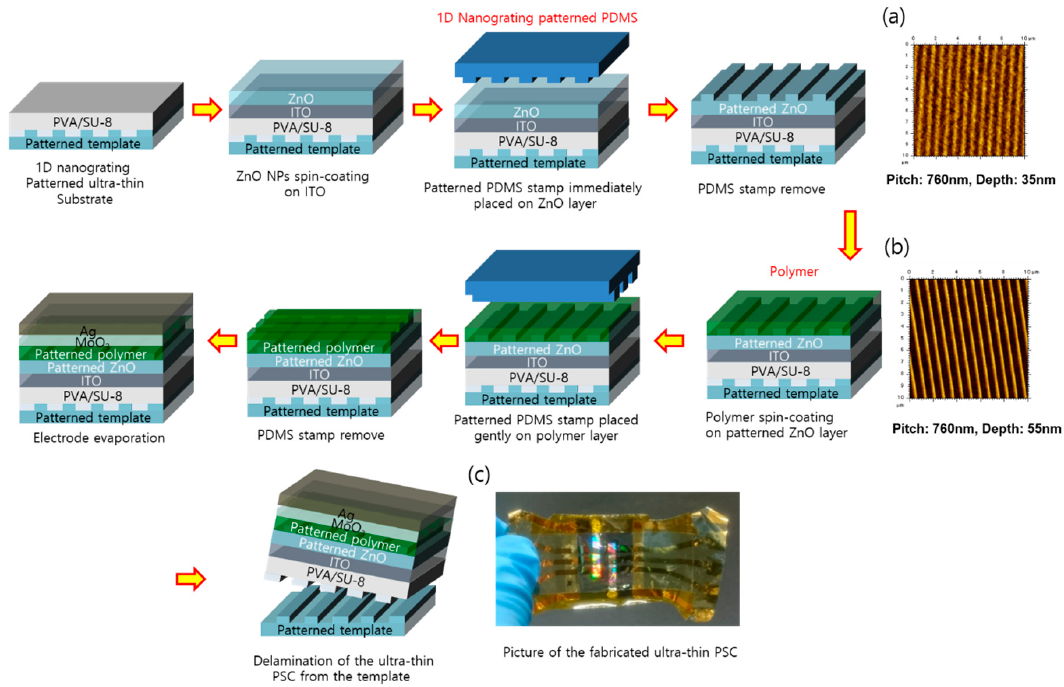
Figure 4. Schematic illustration of the fabrication process for triple-patterned polymer solar cells (PSCs) with 1D nanograting pattern by soft nano-imprinting lithography using a PDMS mold. Inset pictures show the ( a ) topology of patterned electron transfer (ZnO) layer, ( b ) topology of patterned photoactive layer, and ( c ) fabricated ultrathin PSC in this work.